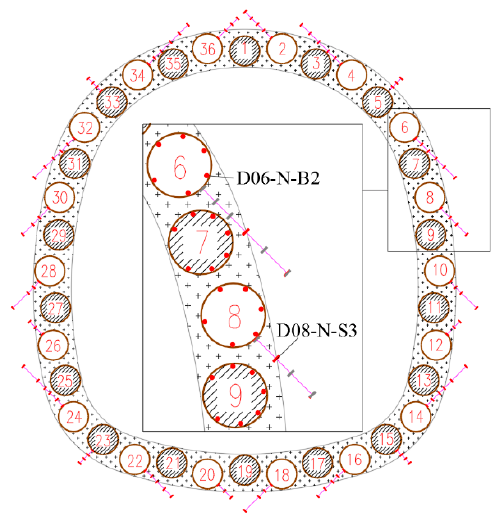
Figure 3. Schematic of a typical measuring face N.